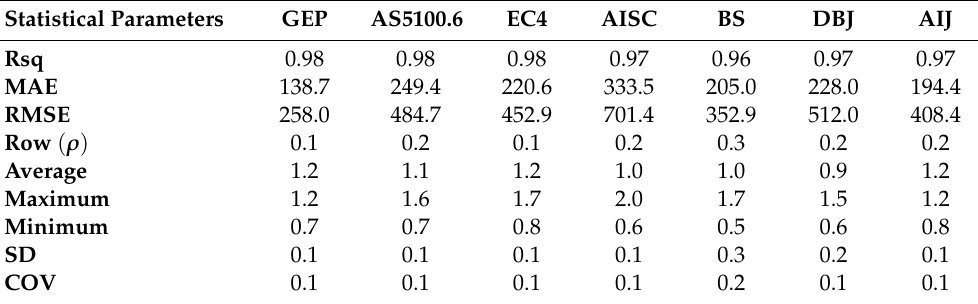
Table 6. Axial strength prediction models overall performance.